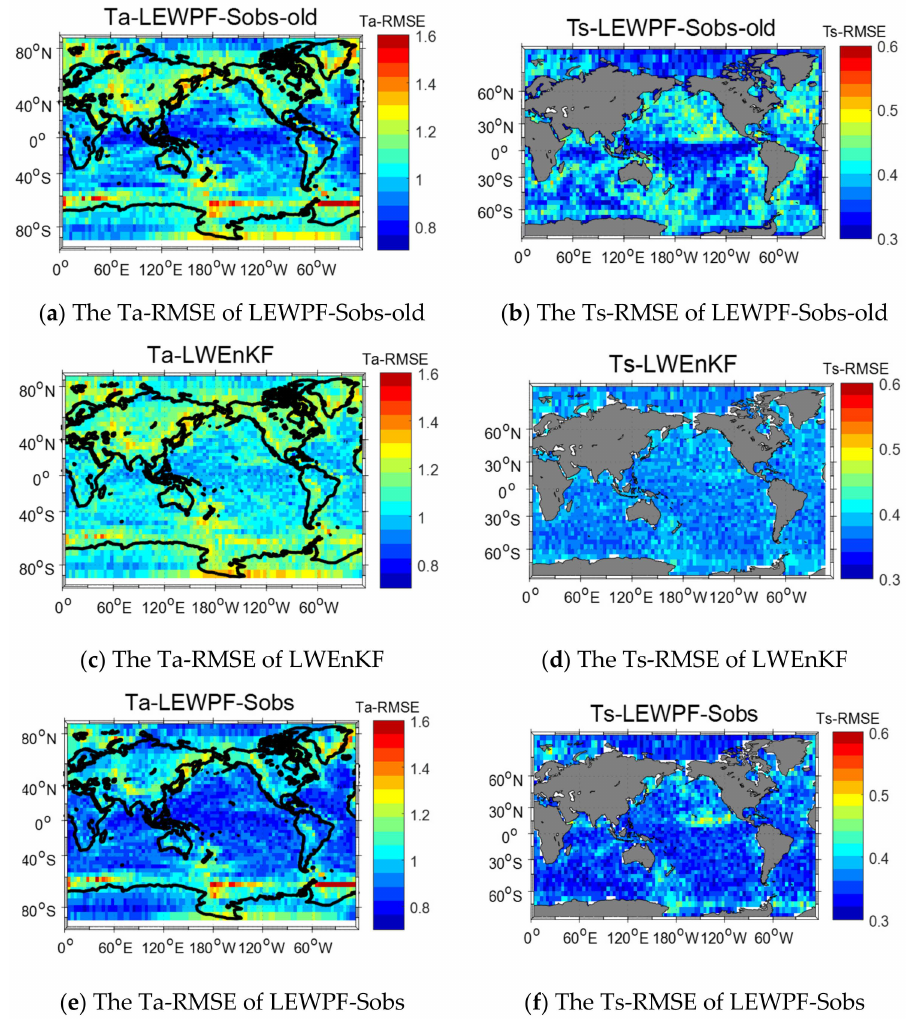
Figure 6. The spatial distribution of annual average RMSE of panel ( a , c , e ) the atmospheric tempera- ture ( T a ) RMSE with respect to LEWPF-Sobs-old, LWEnKF and LEWPF-Sobs. The panel ( b , d , f ) are similar to panel ( a – c ) but for the ocean temperature ( T s